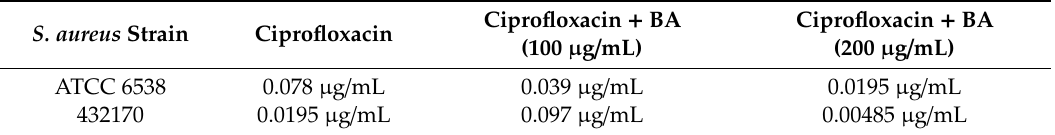
Table 1. Modulatory effect of betulinic acid (BA) on the Ciprofloxacin action towards Staphylococcus Modulatory e ff ect of betulinic acid (BA) on the Ciprofloxacin action towards aureus strains. Staphylococcus aureus strains.